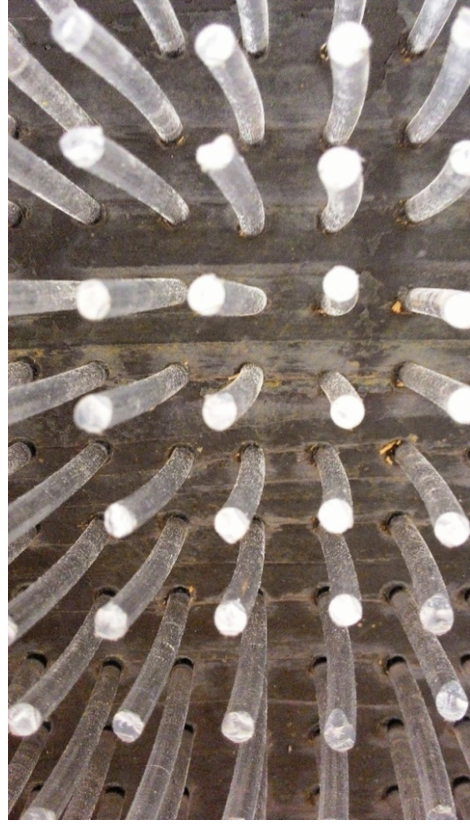
Figure 16. Sample with plastic optical fibers (POF).